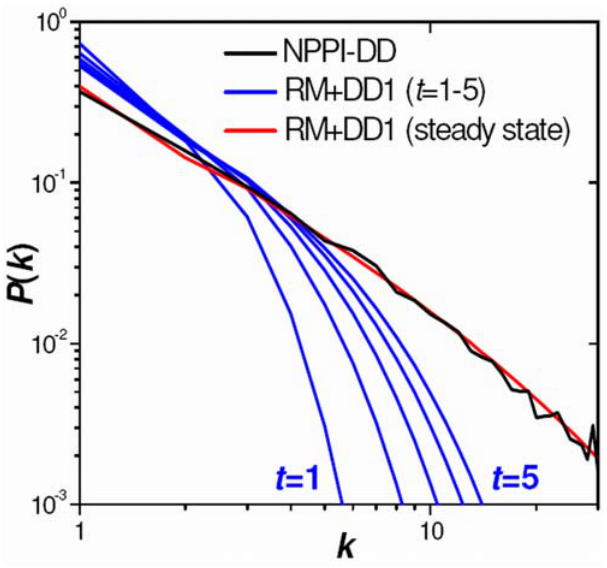
Figure 6. Degree Distributions Representative of PPI Networks and of the RM + DD1 Model. The normal PPI degree distribution (NPPI-DD) (black) is determined by averaging over eight PPI networks. Degree distributions of the RM + DD1 model are shown at time steps 1–5 (blue) and the steady state (red).